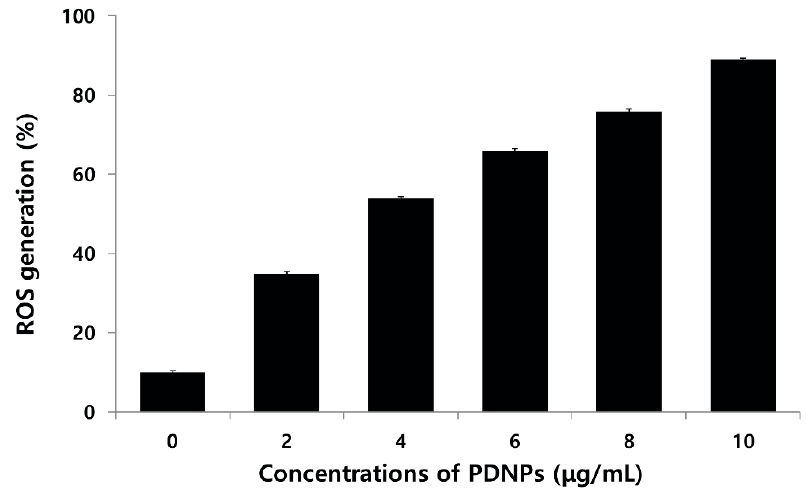
Figure 9. Palladium nanoparticles (PdNPs) induce reactive oxygen species (ROS) generation in human ovarian cancer cells. Relative fluorescence of 2 ′ ,7 ′ -dichlorofluorescein was measured at excitation and emission wavelengths of 485 and 530 nm, respectively, using a spectrofluorometer. Results are mean ± standard deviation (SD) of three independent experiments. Treated groups showed statistically significant differences from control group using Student’s t -test, p < 0.05.